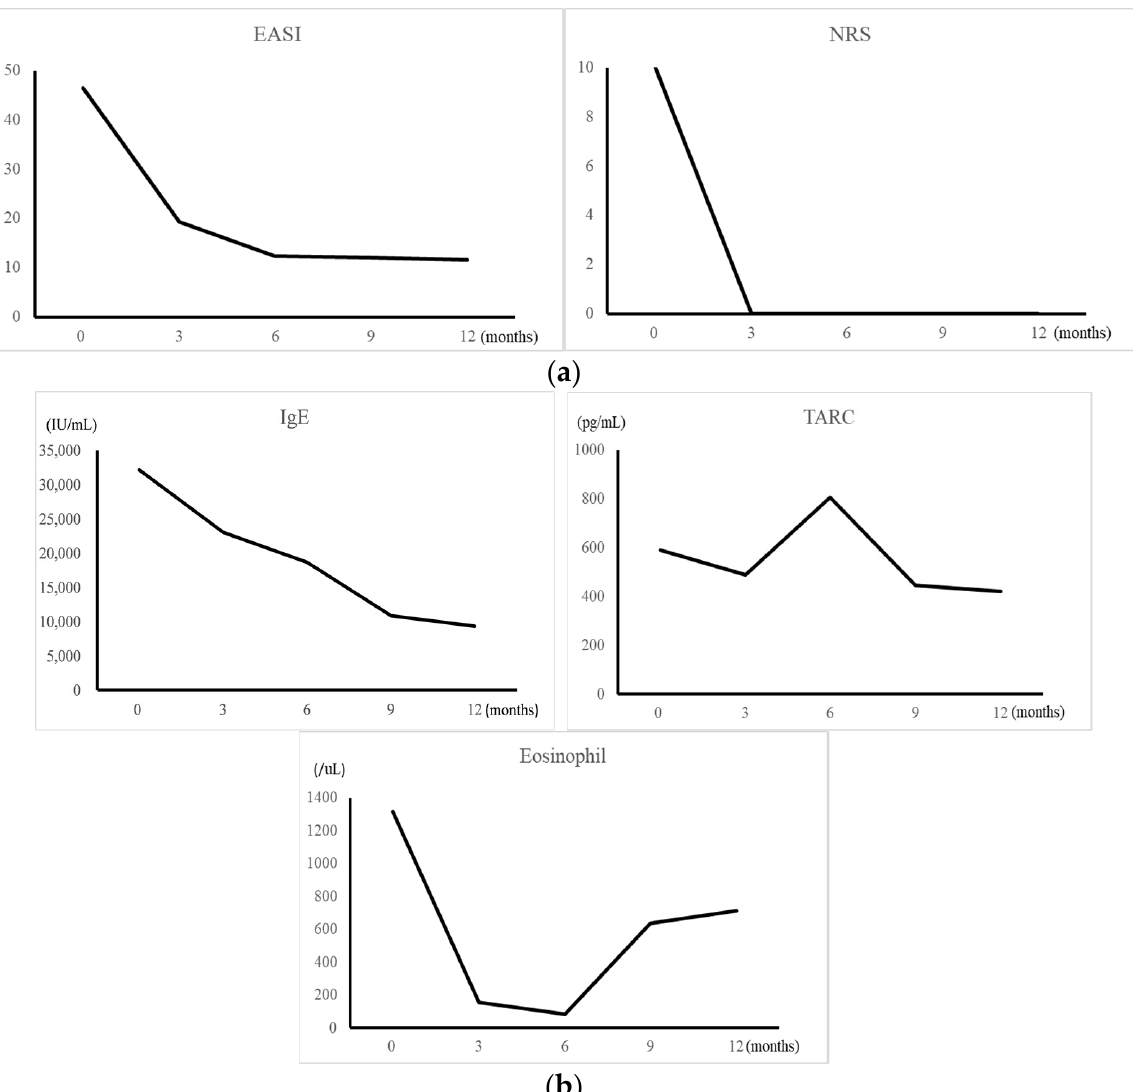
Figure 4. ( a ). Changes in the numerical rating scale (NRS) for pruritus and the Eczema Area and Severity Index (EASI) for atopic dermatitis before and after the administration of dupilumab. The x-axis indicates the elapsed time from the administration of dupilumab; the y-axis indicates EASI or NRS. ( b ). Changes in serum IgE, thymus and activation-regulated chemokine (TARC) and eosinophil before and after the administration of dupilumab. The x-axis indicates the elapsed time from the administration of dupilumab; the y-axis indicates IgE, TARC or eosinophil.